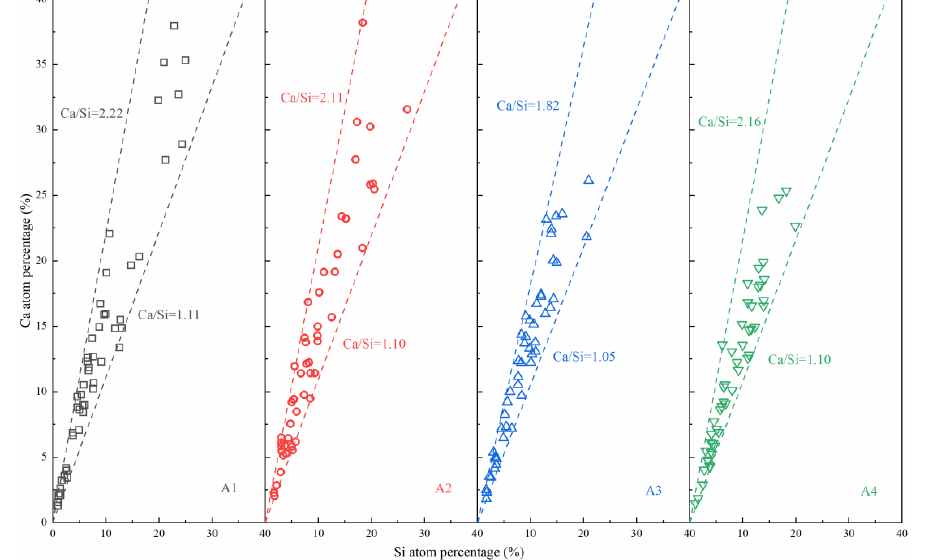
Figure 10. Atom percentages of Ca and Si in Figure 9.